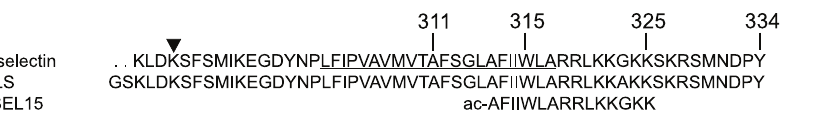
Figure 1. Sequences of L-selectin-derived peptides CLS and LSEL15. The sequence of C-terminal portion of human L-selectin, including entire transmembrane and cytoplasmic domains, is shown on top, with key residue numbers included. Residues in the transmembrane domain are underlined. The filled triangle marks the shedding cleavage site in L-selectin. The N-terminal end of LSEL15 is acetylated (ac-).